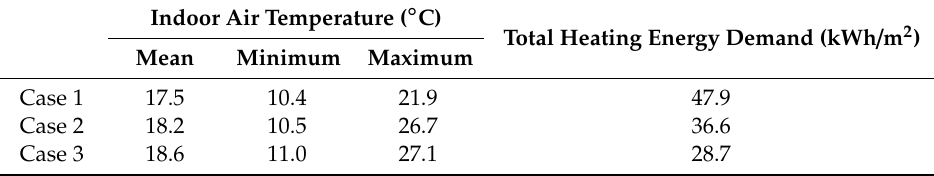
Figure 12. Comparisons of indoor air temperature and heating energy demand on heating design day. ( a ) Indoor air temperature for studied cases; ( b ) Heating energy demand for studied cases. Table 2. Summary of indoor air temperature and total heating energy demand in heating season.